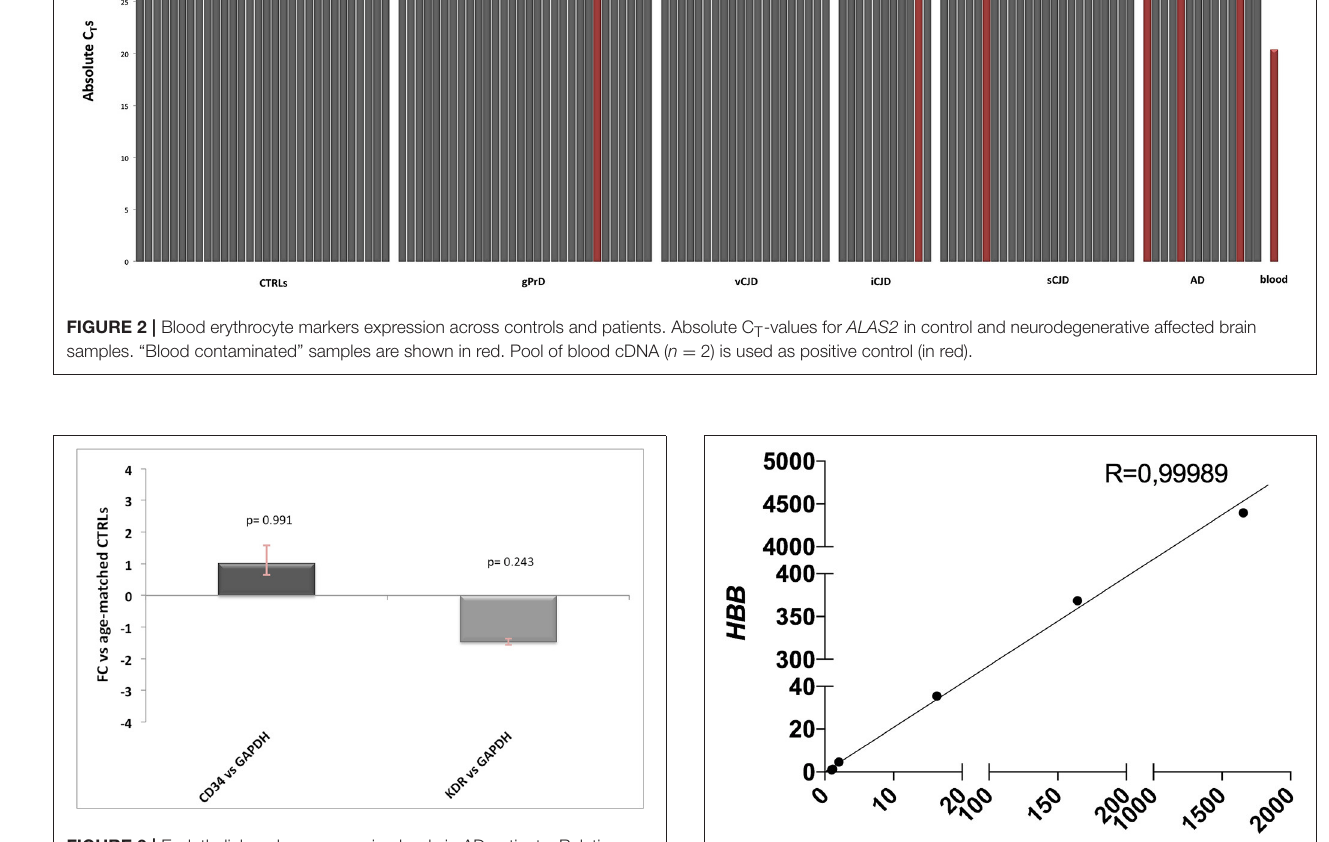
FIGURE 3 | Endothelial markers expression levels in AD patients. Relative expression levels of CD34 and KDR normalized against GAPDH in AD patients vs. age-matched controls, with related p -values. For FC-values smaller than 1 the reciprocal ( − 1/FC) is reported, for ease of representation. FIGURE 4 | Correlation between HBB and ALAS2 expression in brain samples (pool of 2 AD samples) containing serially diluted amounts of blood cDNA (pool of 2 healthy controls and 2 patients). R, Pearson correlation